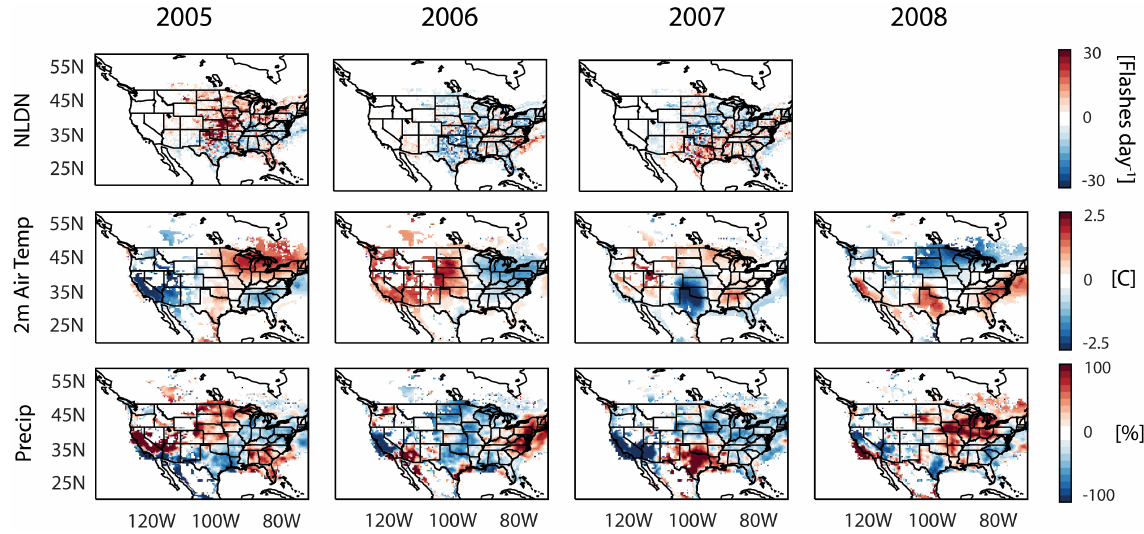
Fig. 3b. Same as Fig. 3a except for flash counts from the National Lightning Detection Network (NLDN) (mean daily flashes), Temperature ( ◦ C), Precipitation (%). NLDN flashes are X3 higher in 2008 than 2005–2007 for reasons that are unclear as such we take the anomaly from 2005–2007 mean.